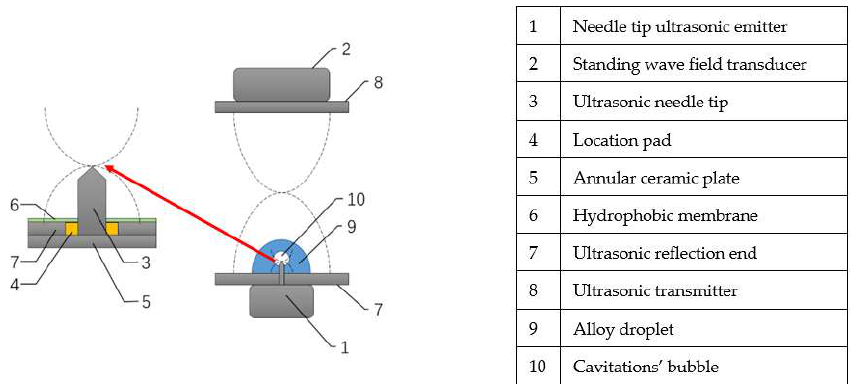
Figure 2. The structure and composition of the ultrasonic compound fields.